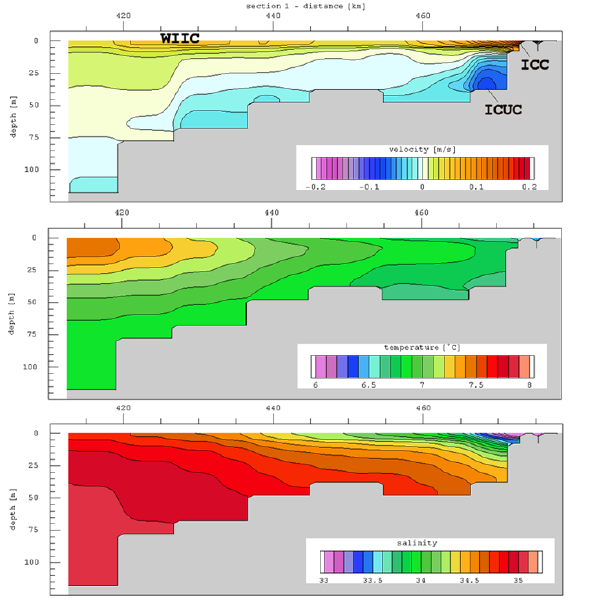
Fig. 9. Simulated 1992–2006 mean of flow (positive (red) values denote northward flow), temperature and salinity across section 1 (eastern end). See Figure 6 for section